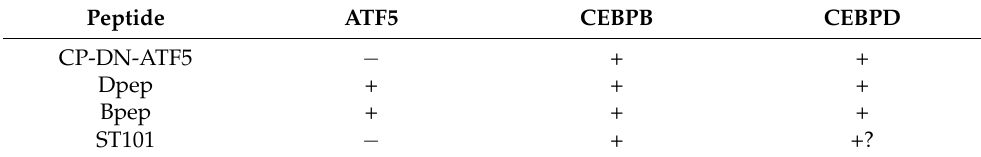
Table 1. Target specificities of reported cell-penetrating peptides with respect to ATF5, CEBPB and CEBPD. Data are presently unavailable for association of ST101 with CEBPD, but this appears likely given the similarity of its leucine zipper sequence to that of